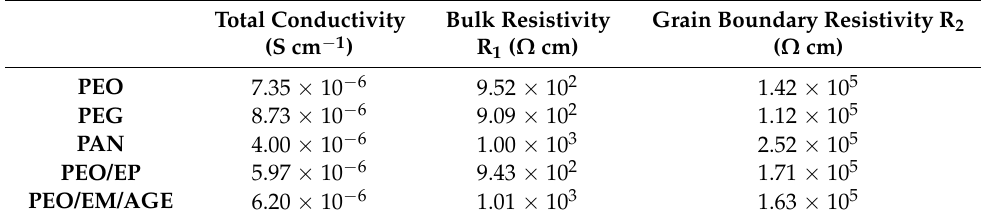
Table 3. The total conductivity for La 0.5 Li 0.5 TiO 3 and 10% polymer-composite samples obtained from bulk and grain bound- ary resistivities at room temperature.